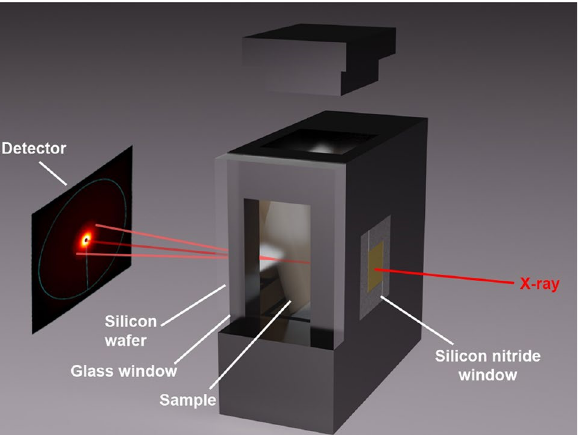
Figure 6. Rendering (Blender v2.90.1 https:// www. blend er. org/) of the in-situ measurement cell and the x-ray pathway through it. The measurement cell consists of anodized aluminium and is sealed with a silicon wafer, a silicon nitride window, a museum-glass window and an aluminium